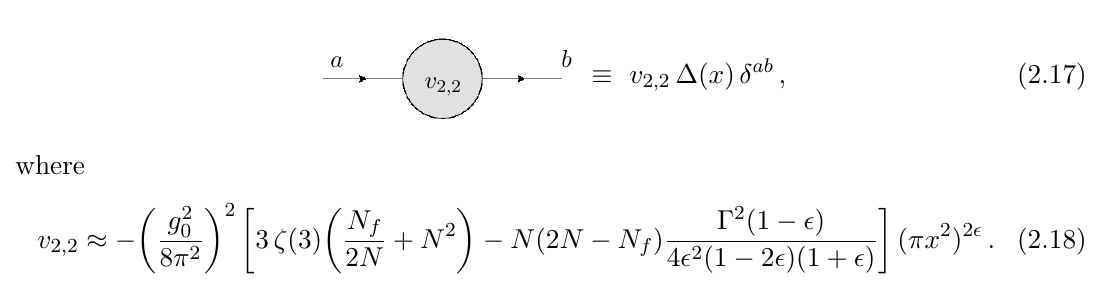
Figure 9 . Irreducible two-loop diagrams in the di(cid:11)erence theory that yield the v ( A ) the scalar propagator is